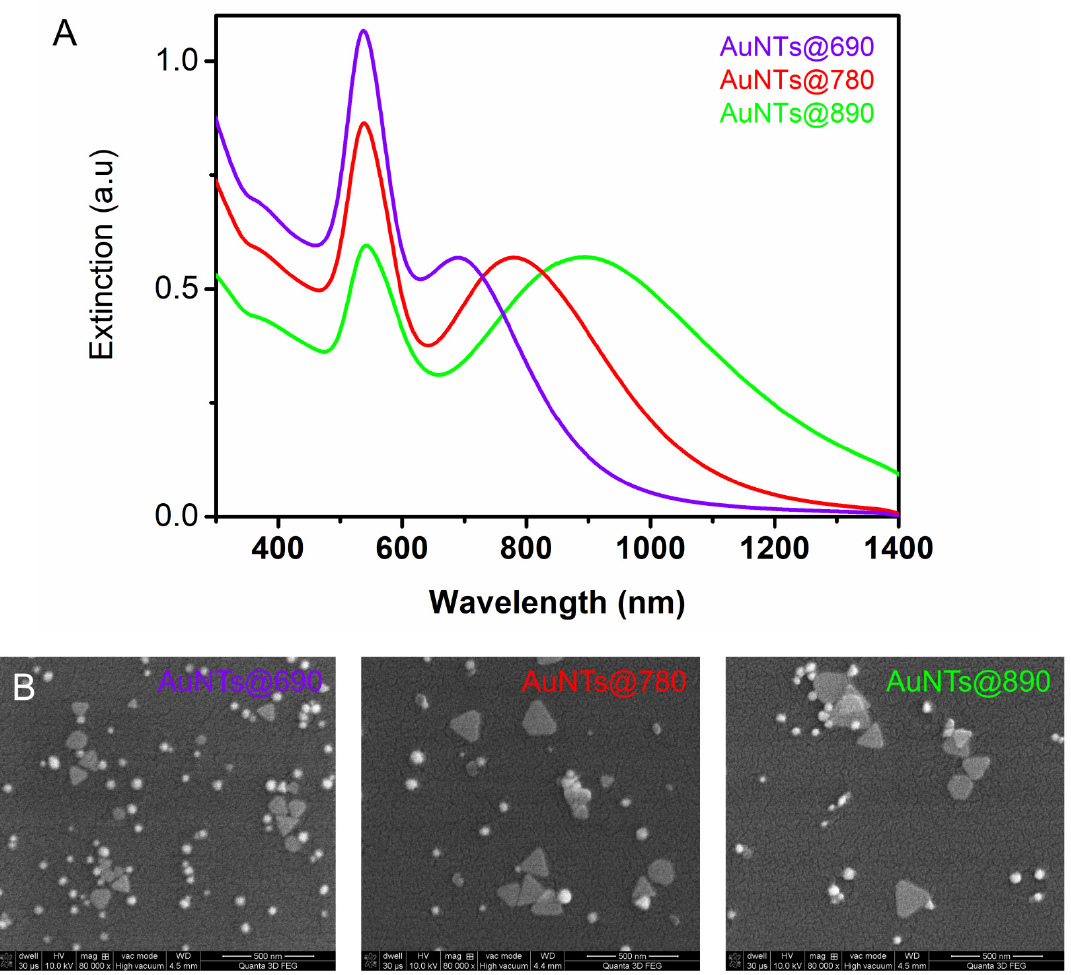
Figure 1. ( A ) LSPR spectra of gelatin coated AuNTs ( B ) SEM images of AuNTs. The scale bars represent 500 nm.